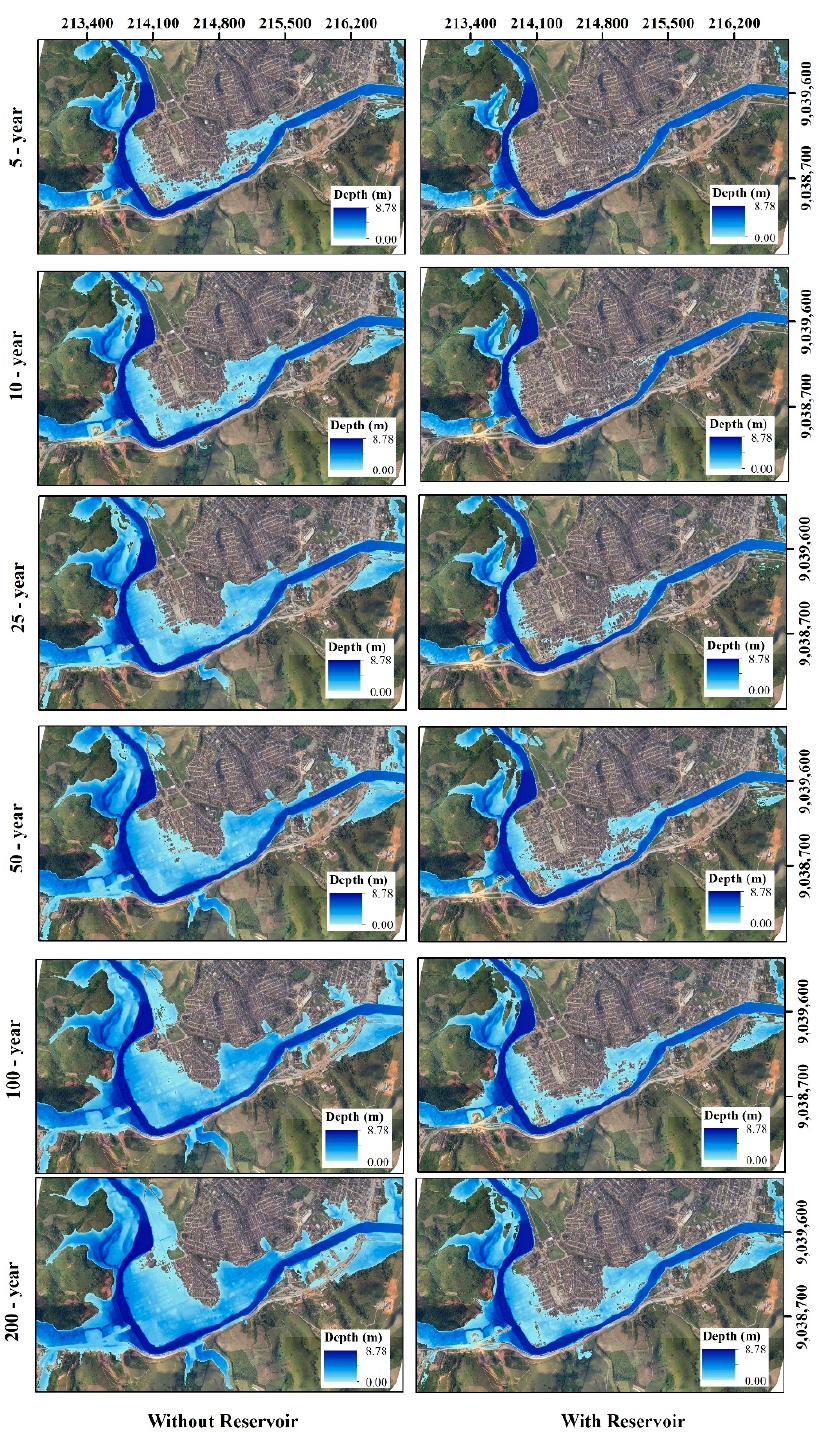
Figure 4. Floodplain simulations with and without the Serro Azul reservoir.